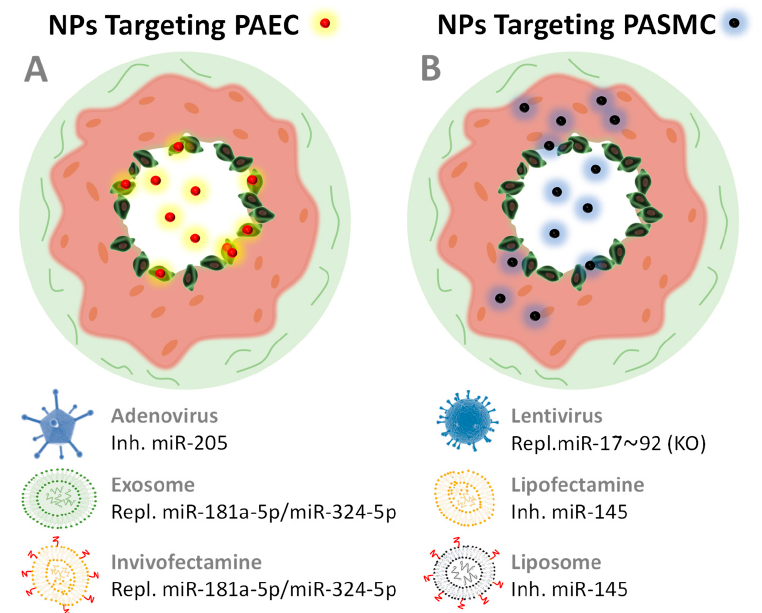
Figure 5. Schematic drawing of a cross section of two pulmonary arteries that develop PH and are being treated with nanopharmaceuticals (represented as small red and black spheres) that target the endothelial cells of the PAEC arteries ( A ) or smooth muscle cells PASMC ( B ). Endothelial dysfunction leads to a patent state in which NPs can leak into the pulmonary vasculature and reach PASMC more easily than in healthy arteries. The nanovectors collected in Table 3 are shown